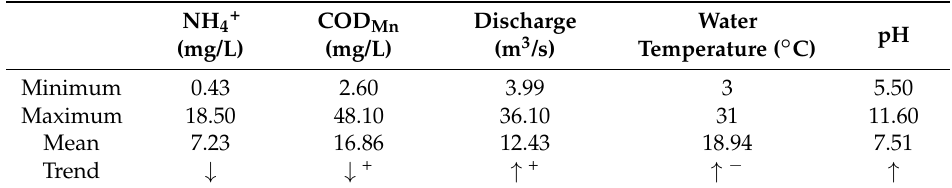
Table 1. The trend results of NH 4+ , COD Mn , and discharge.